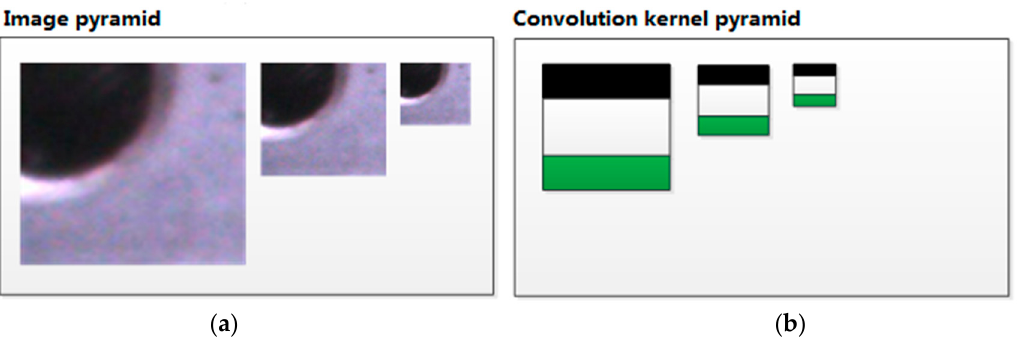
Figure 6. Image pyramid and convolution kernel pyramid. ( a ) Image pyramid; ( b ) Convolution kernel pyramid.